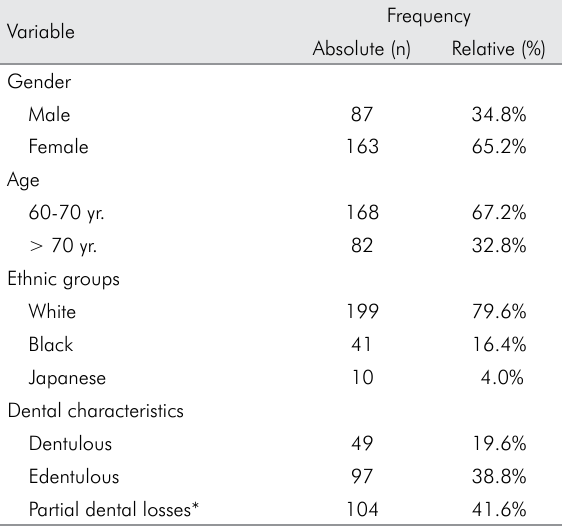
Table 2. Characterization of the study population.